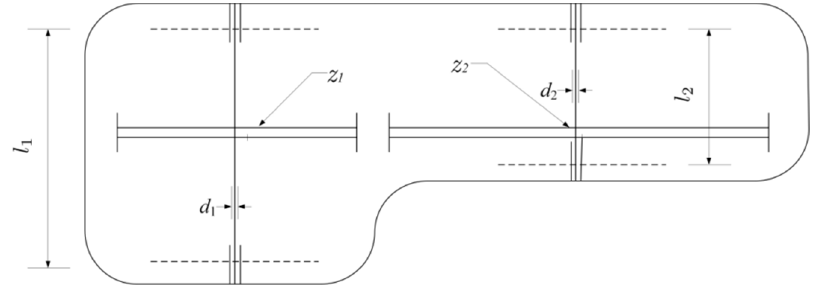
Figure 12. Schematic view of the Speed Reducer design.